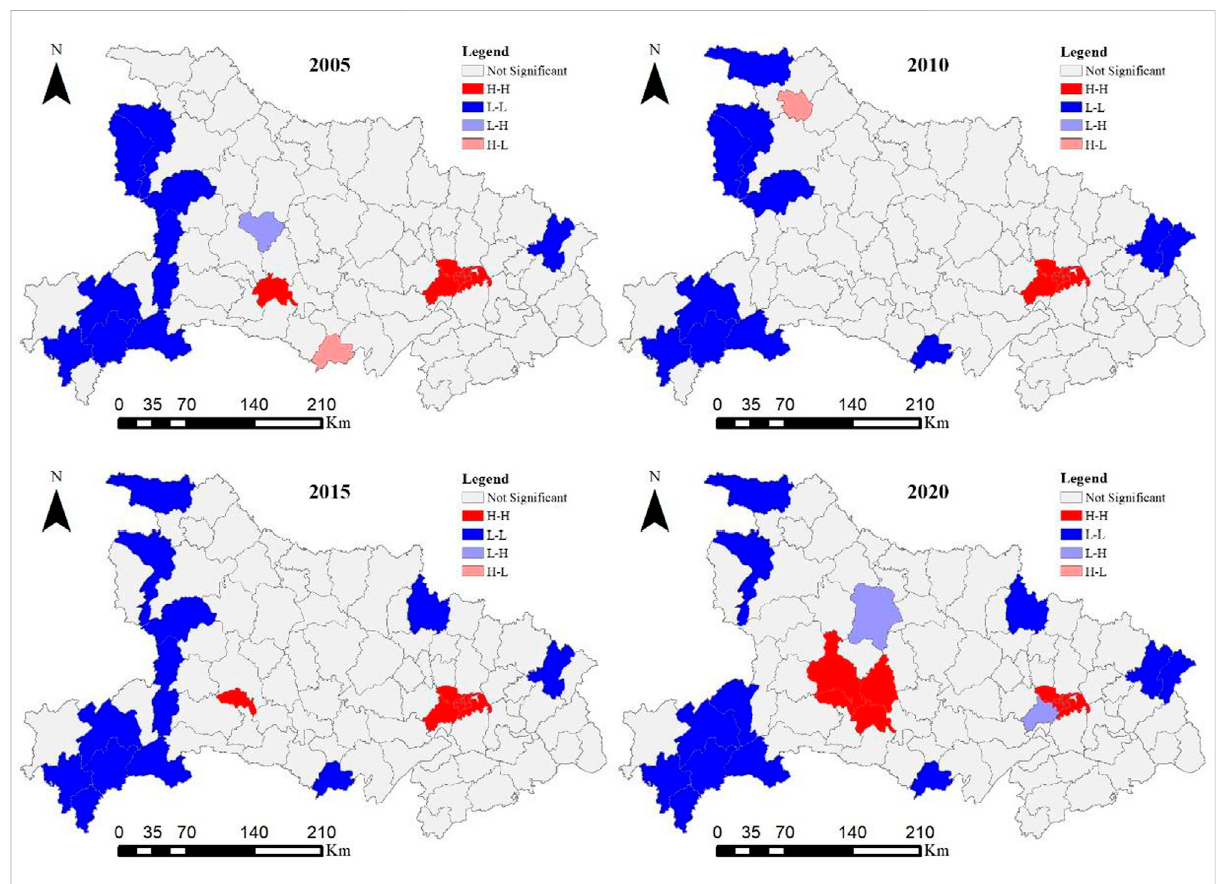
FIGURE 7 Local indicators of spatial association (LISA) of county economy in Hubei